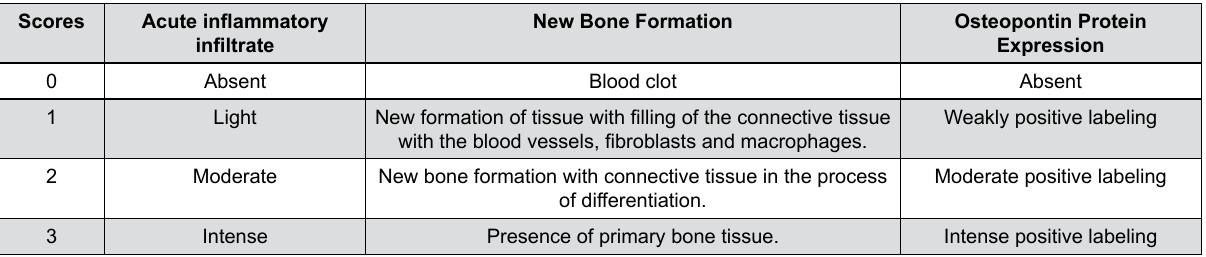
Figure 1- Scores assigned to histopathologic events for the semi-quantitative evaluation of the acute inflammatory infiltrate, new bone formation and osteopontin